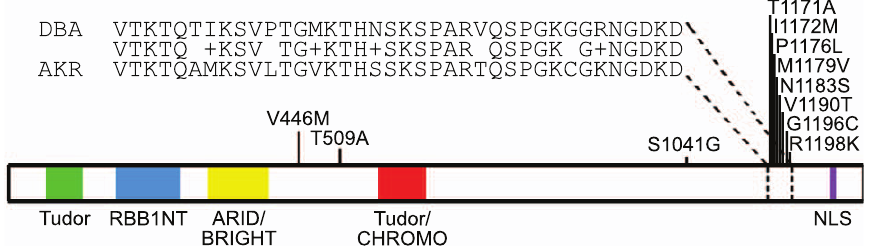
Figure 2. Arid4b germline amino acid sequence variants. Substitutions in the AKR allele are shown relative to a consensus sequence that is identical between DBA, FVB, and C57Bl/6. The + symbol indicates conserved